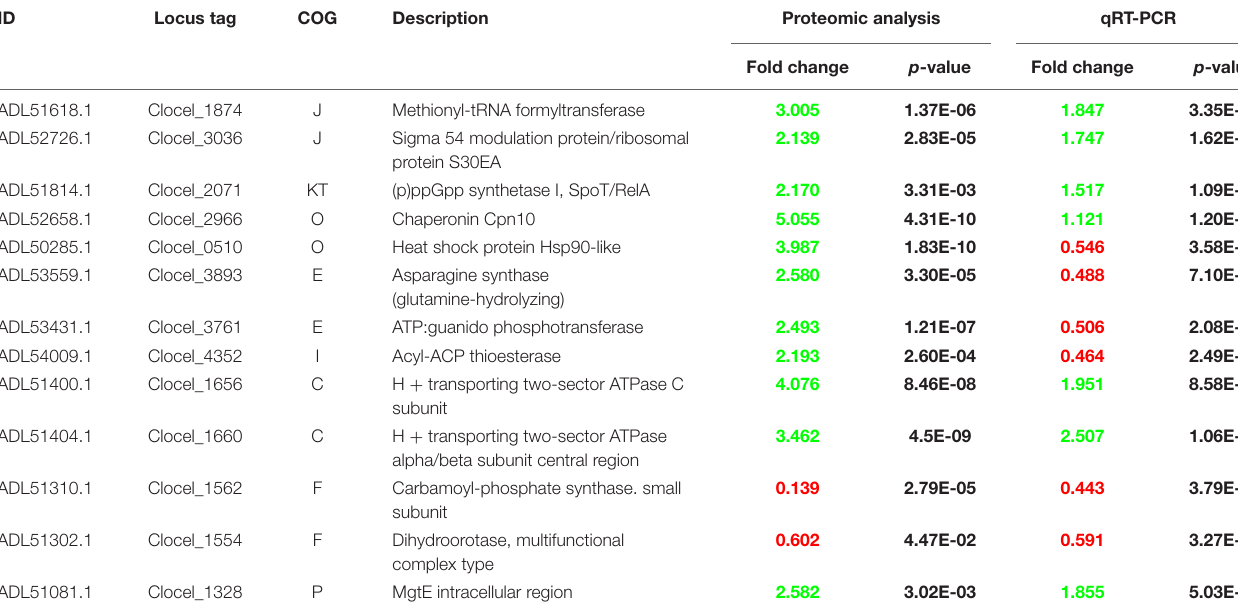
The expression fold-change (ratio between butanol-supplemented and control cultures) and t-test p-value for each protein/gene is indicated. Fold change of up- and down-regulated proteins/genes are indicated in red and green respectively.